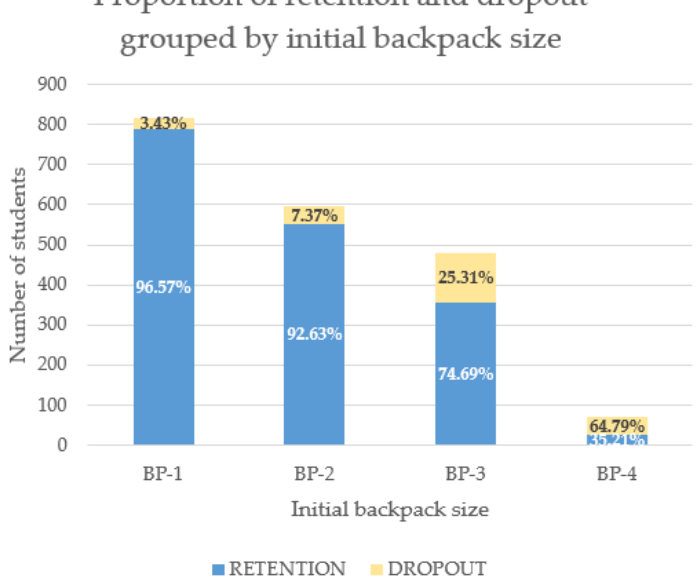
Figure 9. Number and proportion of students who, according to the BPPM-S model, either finished in RETENTION or in DROPOUT, grouped according to the initial backpack size.